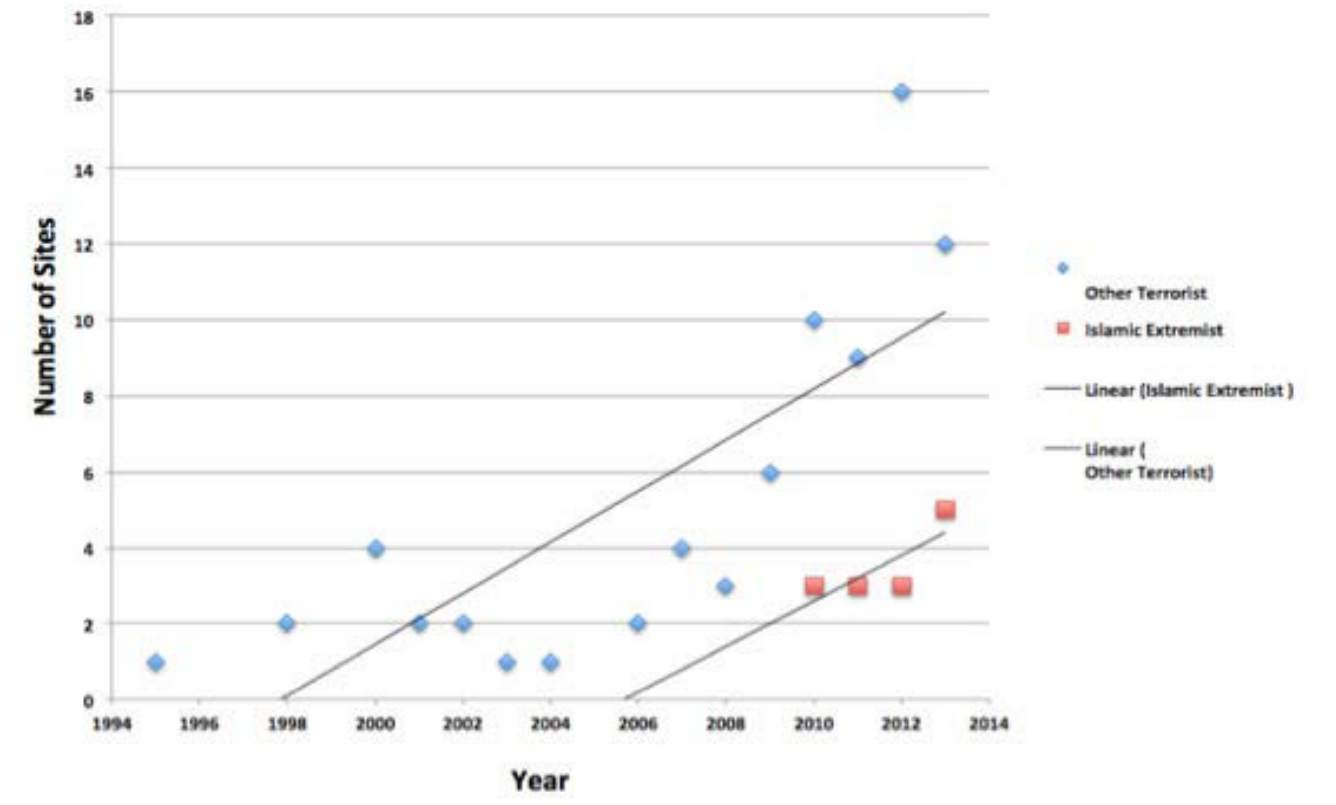
Figure 6: Count of terrorist web site mapped against creation date (red squares represent Islamic Extremist sites; blue diamond’s represent all other terrorist category